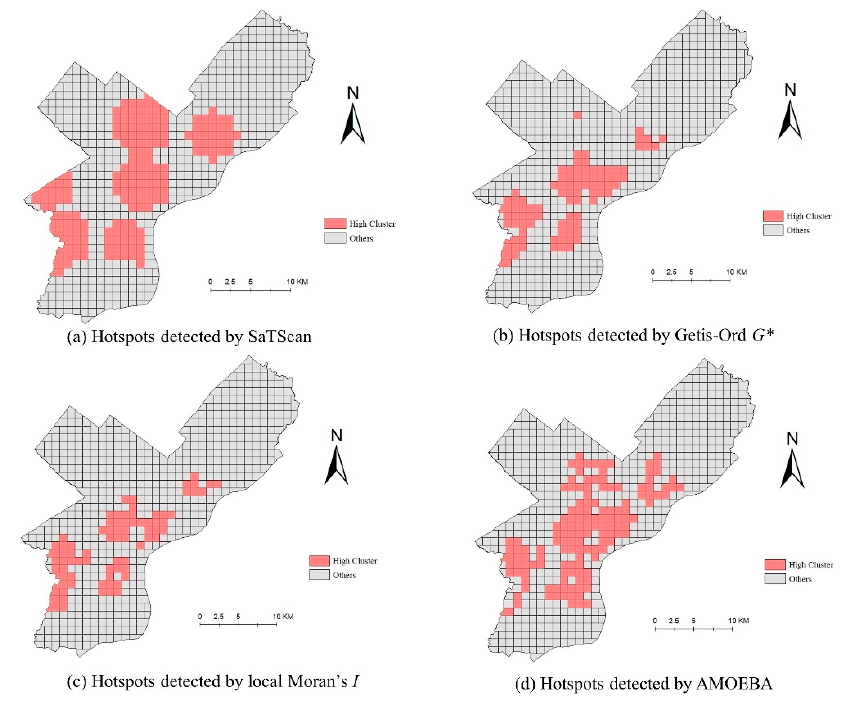
Figure 5. The hotspot detection result of real crime data.